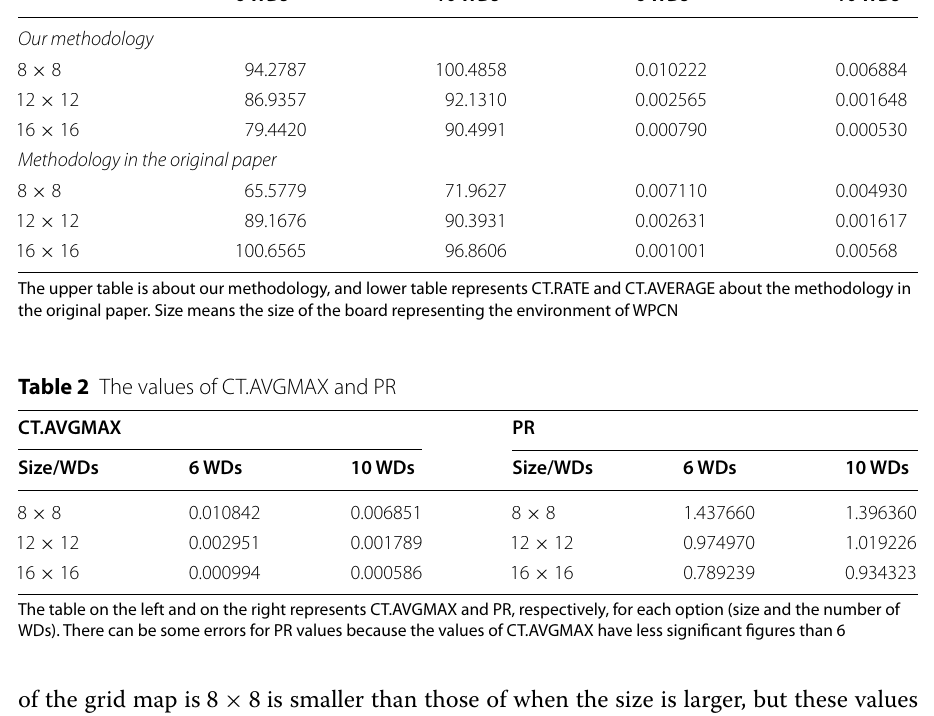
Fig. 7 Comparison of CT.RATE(%) of our methodology and the methodology in the original paper. Our methodology shows better performance than the methodology in the original paper for size 8 the two methods show nearly the same performance for size 12 16 performance for size 16 ×